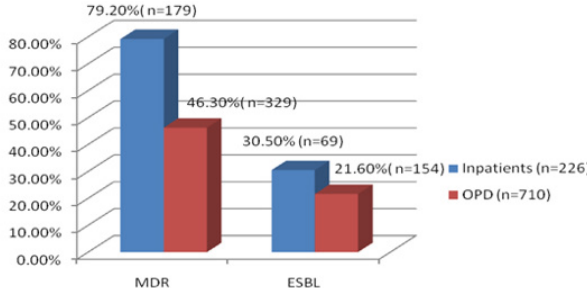
Figure 2: Rate of MDR and ESBL producing Enterobacteriaceae isolates in clinical samples from in-patients and